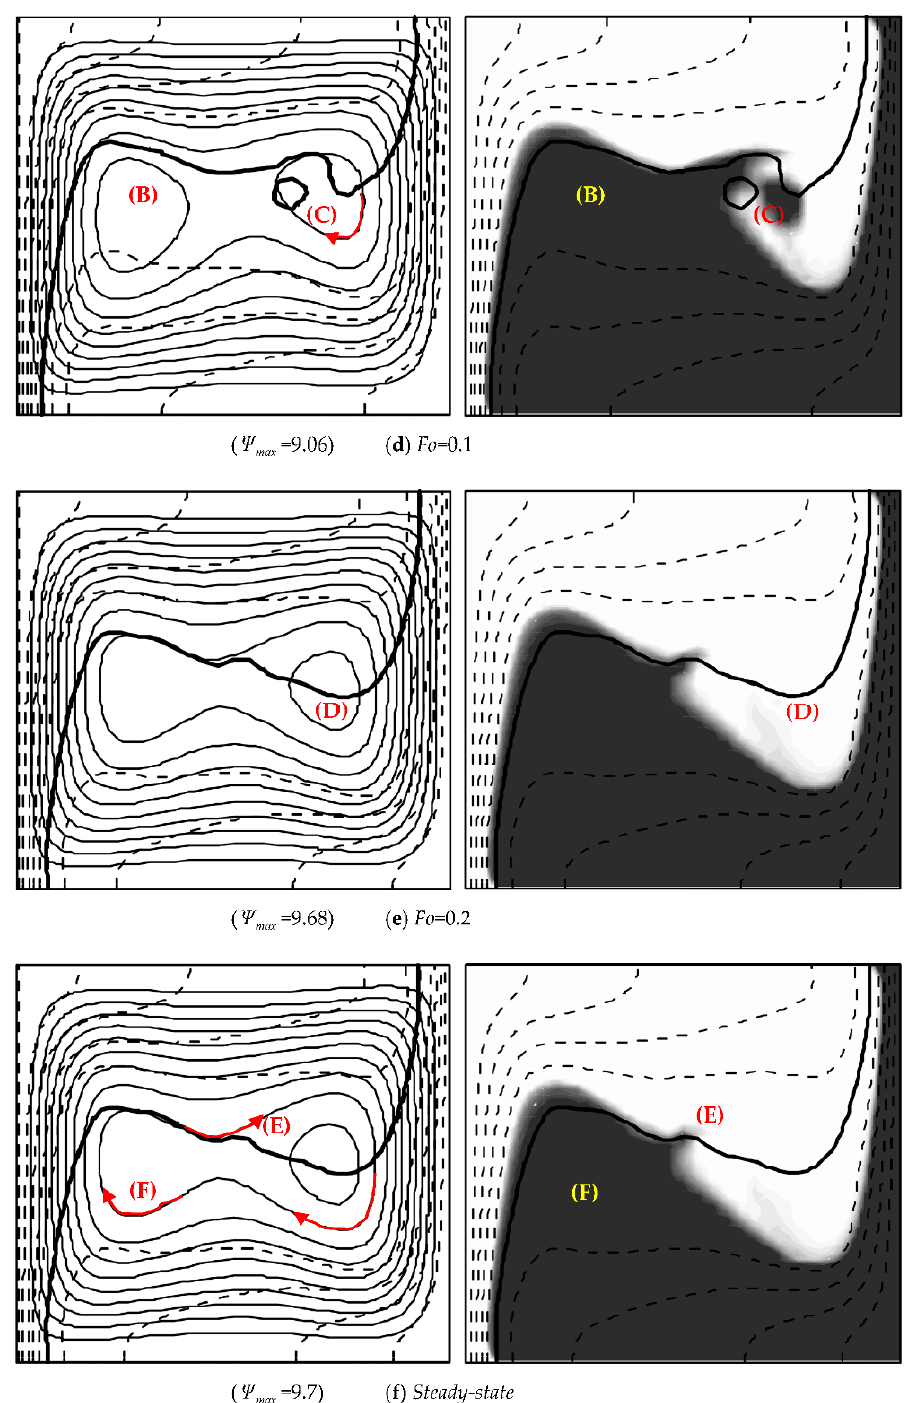
Figure 4. Transient evolution of the flow field (solid line), temperature distribution (dashed line), and PCM solid – liquid phase distribution (shaded area is solid-phase PCM particles; Ra T = 10 5 , Ste = 0.05, Sb = 1, c i = 5%).